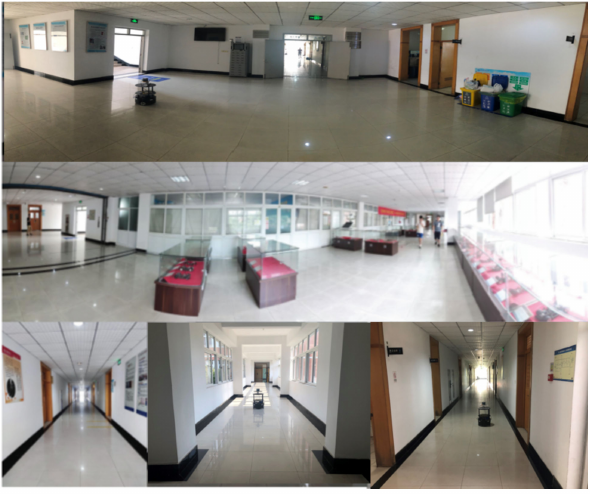
Figure 12. Experimental real